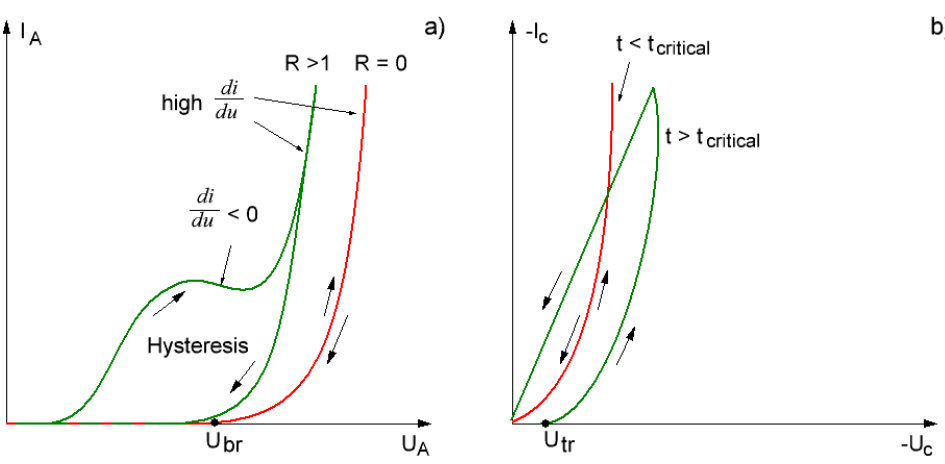
Figure 2. Transient current–voltage curves in PEO for anodic ( a ) and cathodic ( b ) polarisations. Symbols t and R have the same meanings as in Figure 1.